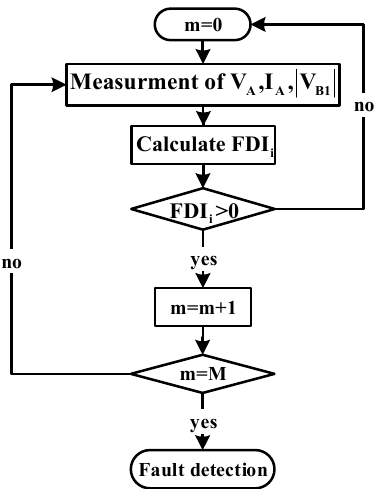
Figure 10. Flowchart of the proposed main protection scheme.